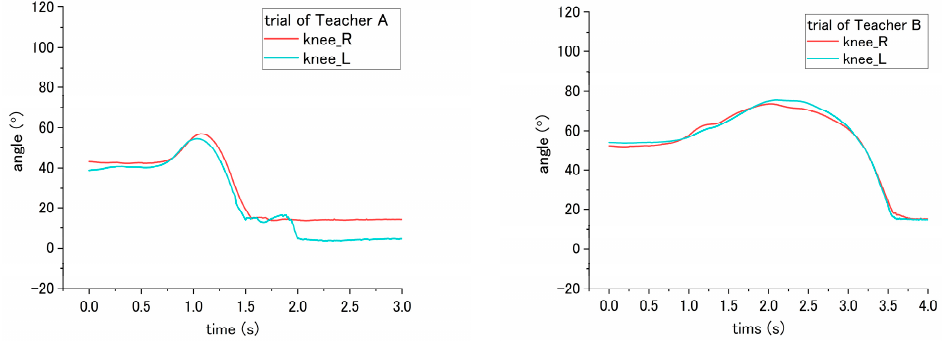
Figure 17. Flexion angle of patient’s knee during step No. 11 when incorrect way was conducted at step No. 6.